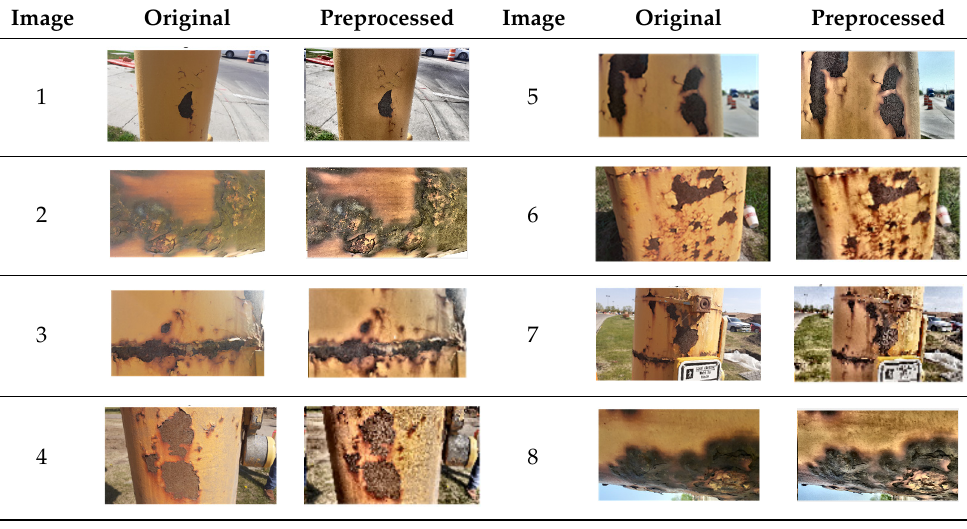
Figure 13. Comparison of quality metrics of original and preprocessed sound images . A comparison of images in the original and preprocessed conditions is presented in Table 4. In Table s 4 and 5, all the brightness values in candela(cd) of different images are presented. Further investigation was performed on the influence of preprocessing on the TPR and TNR values. From the result, it is reported that brightness change did not sig- nificantly affect TNR values. On the other hand, a change in brightness above 10% re- duced the correct detection rate up to 20%. The brightness of all the images except imag- es 5 and 8 changed by less than 10%; the corroded zone segregated from the sound part more clearly. For example, in image 3, the right corner portion of the image was overex- posed to the sun; therefore, the corroded part became blurry. After preprocessing with a 2.32% brightness increment, all the corroded parts became prominent, which finally led to a 9% increment in TPR value. The highest increment in TPR value happened for im- age 4, which is 20% with 3.5% brightness modification. The reason behind this signifi- cant increment can be justified by the binary image presented in Table 6. Table 4. Comparison of images in original and preprocessed condition.